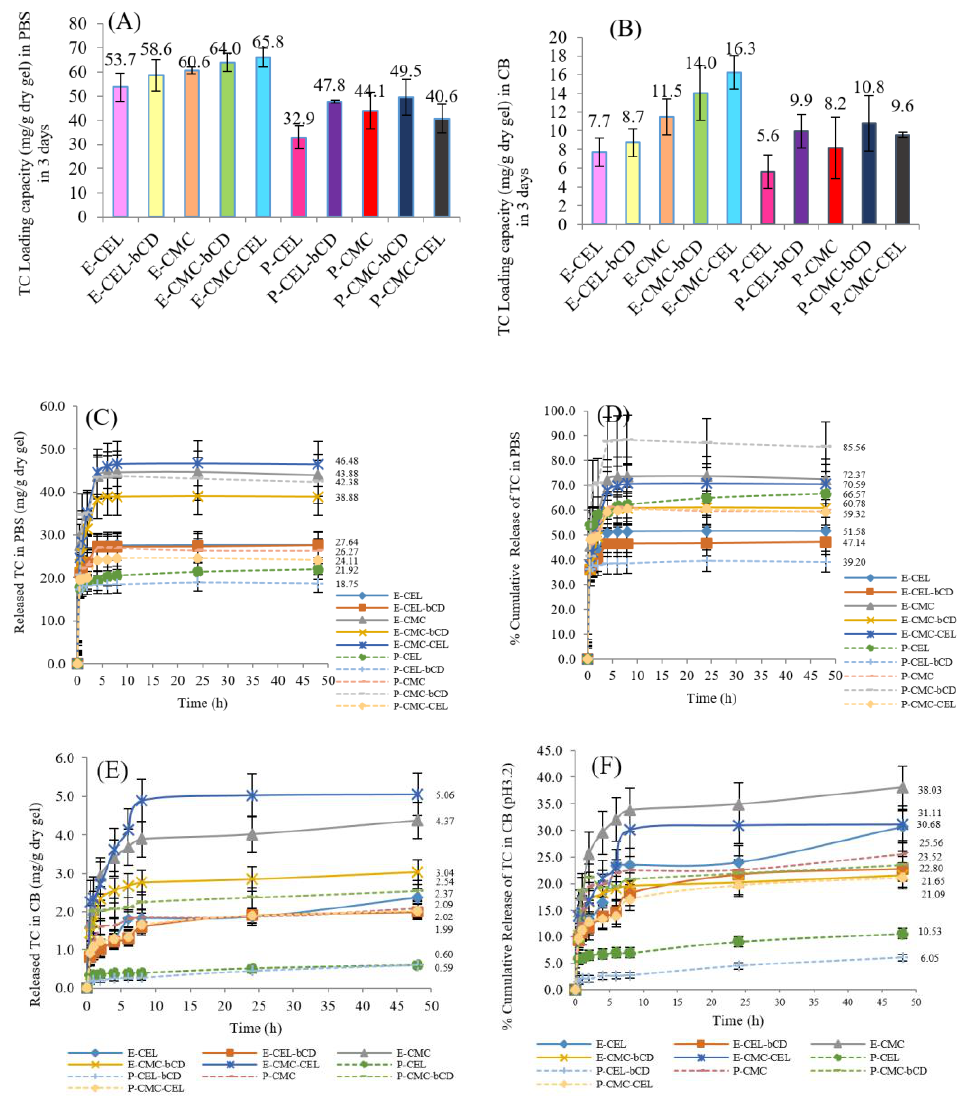
Figure 11. Tetracycline loading amounts in CEL, CEL- β CD, CMC, CMC- β CD and CMC-CEL gels with ECH and PEGDE cross linkers in ( A ) base condition (pH 7.4) and ( B ) acid condition (pH 3.2); Tetracycline release in base condition (pH 7.4) in 2 days: ( C ) cumulative amount of tetracycline release and ( D ) cumulative percentage of Tetracycline release; Tetracycline release in acid condition (pH 3.2) in 2 days: ( E ) cumulative amount of tetracycline release and ( F ) cumulative percentage of Tetracycline release.